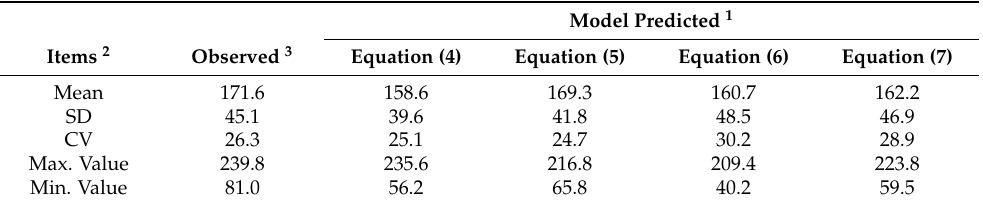
Table 5. Descriptive statistics of the test data set for observed urinary nitrogen excretion (UN; g/d) and UN predicted from models.